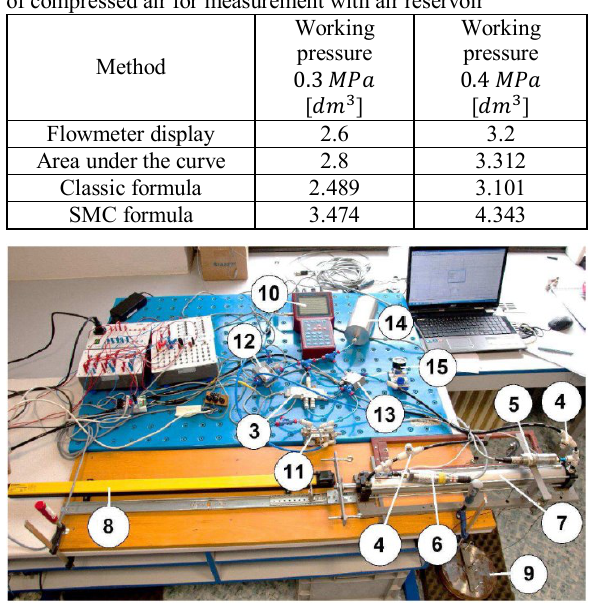
Fig. 12. The realization of measurement with reservoir to accumulated exhaust air